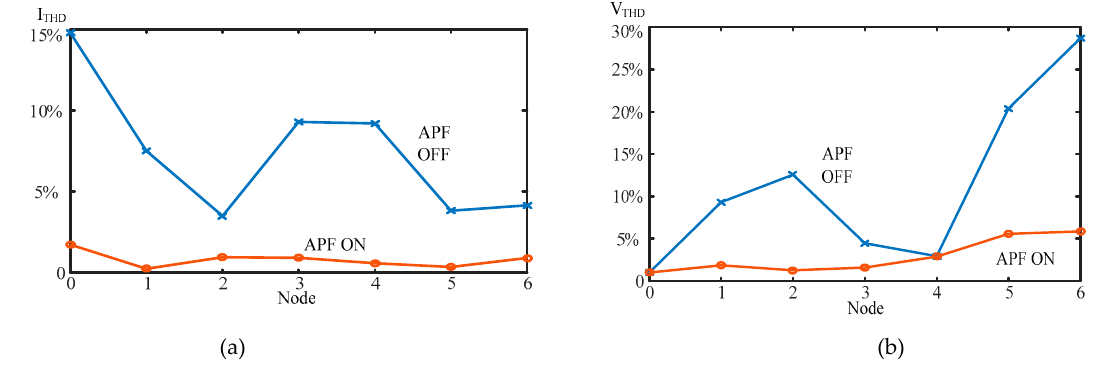
Figure 7. Total harmonic distortion (THD) of seventh harmonic ( a ) current and ( b ) voltage.